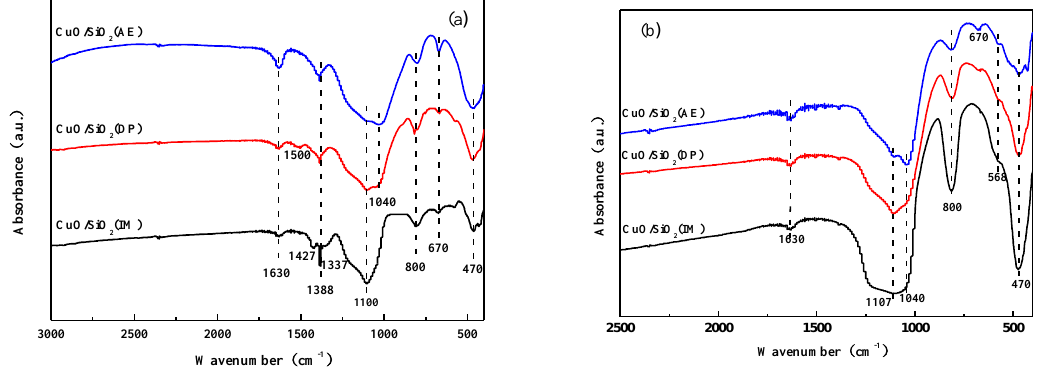
Figure 4. FTIR spectra of CuO / SiO 2 catalysts ( a ) before and ( b ) after calcination.